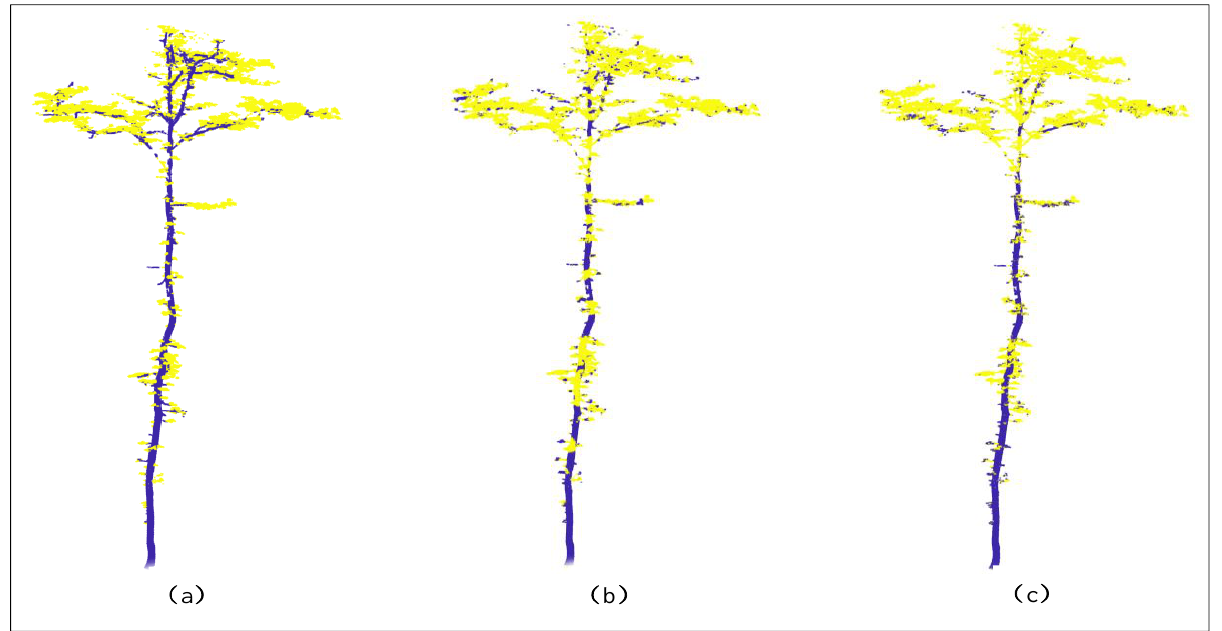
Figure 1. The point cloud of tree 1. (a) the manually classified point cloud; (b) the classification result of single-scale method ( r =